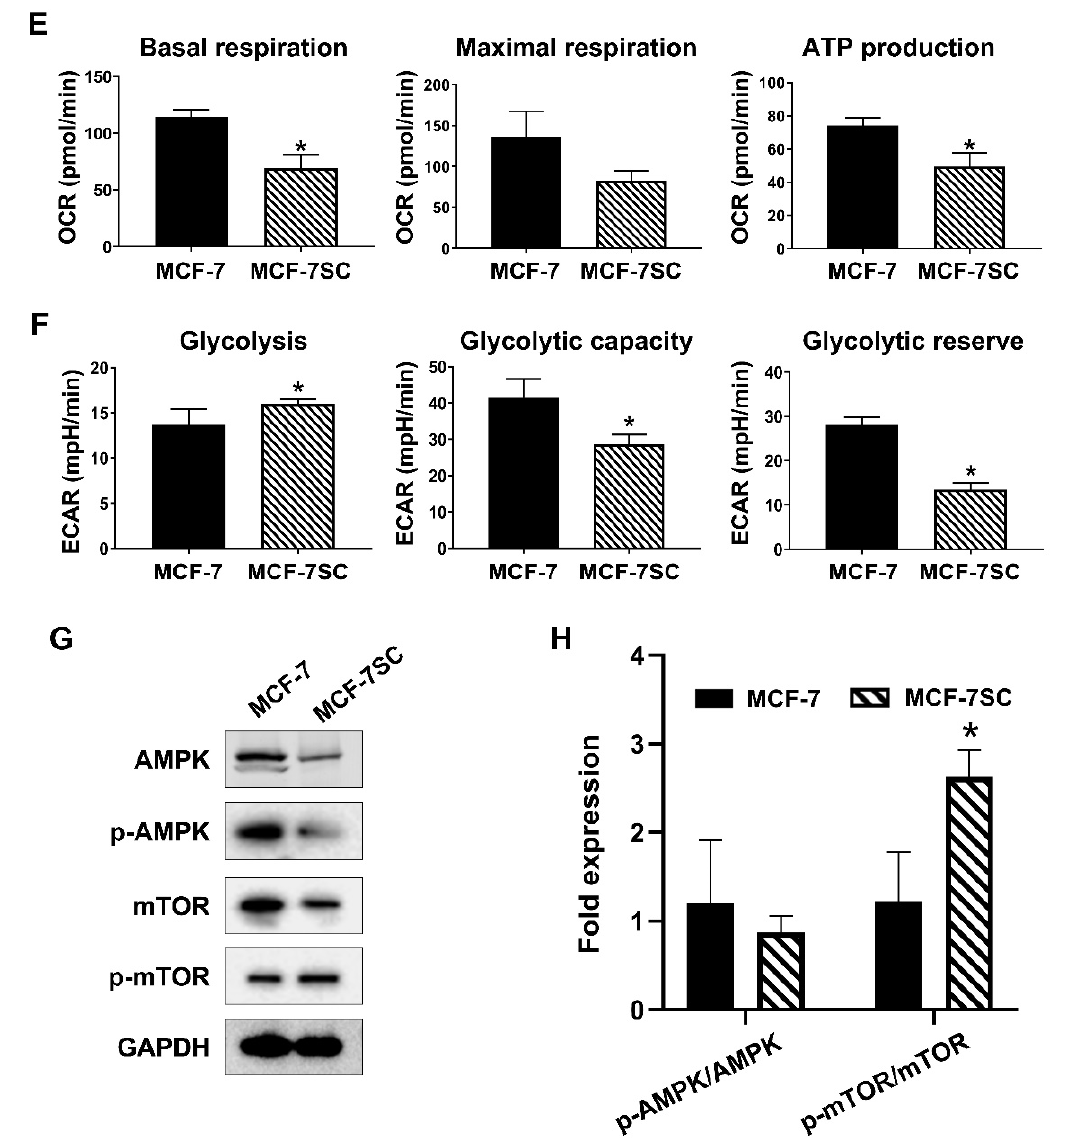
Figure 3. MCF-7SCs preferentially used glycolysis for energy production. ( A ) Up- and downregulated genes associated with glycolysis signaling. ( B ) Validation of the up- and downregulated genes shown in ( A ) using RT-qPCR. ( C ) Oxygen consumption rate (OCR) (pmol/min) and ( D ) extracellular acidification rate (ECAR) (mpH/min). ( E ) Basal respiration, maximal respiration, and ATP production levels. ( F ) Glycolysis, glycolytic capacity, and glycolytic reserve levels. ( G ) Expression of AMPK, p-AMPK, mTOR, and p-mTOR was detected by Western blotting. GAPDH was used as a loading control. ( H ) Quantification of p-AMPK/AMPK, and p-mTOR/mTOR expression normalized to GAPDH. * p < 0.05 vs. control; statistical values represent data from three biologically independent experiments.